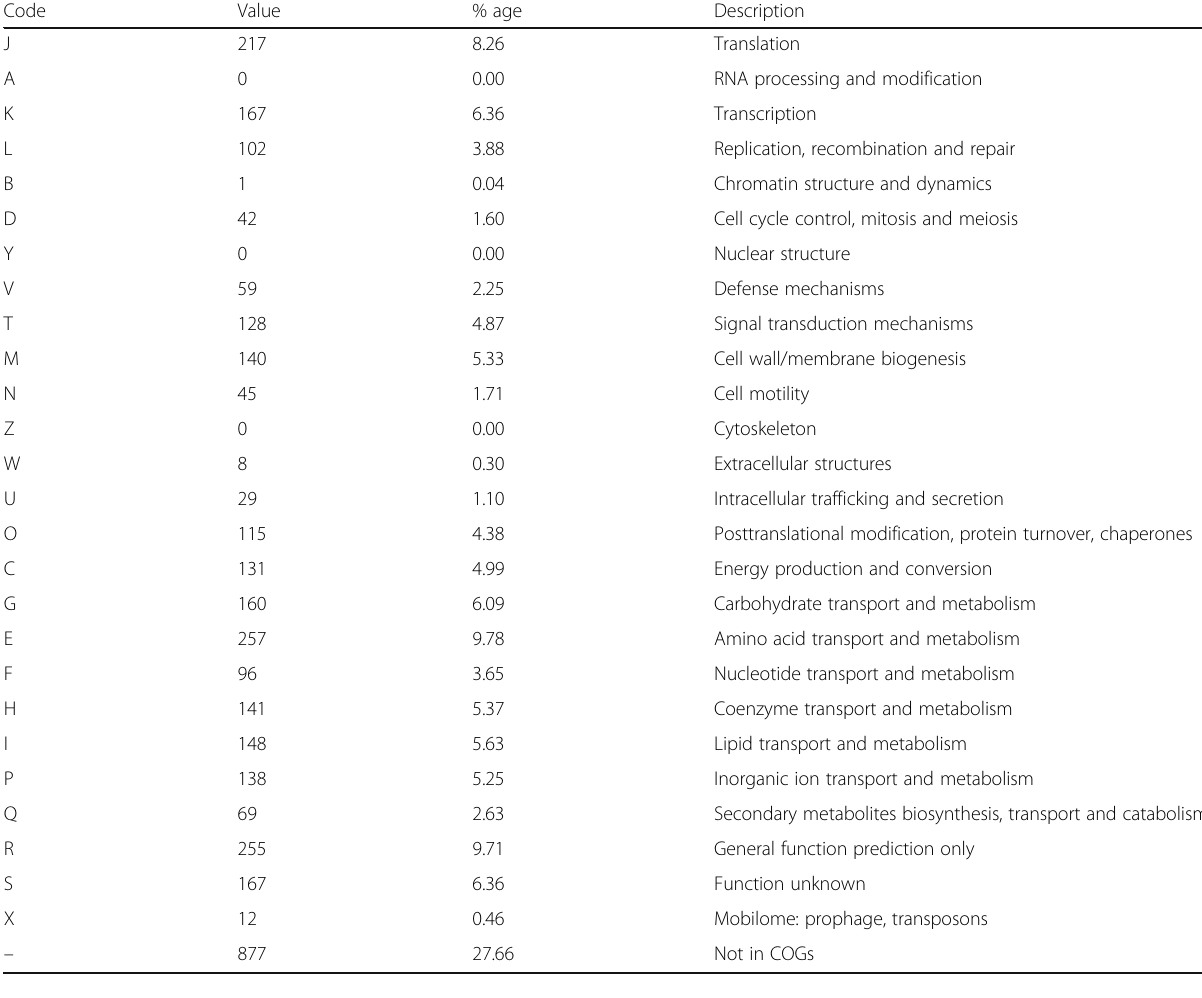
Table 4 Number of genes associated with general COG functional categories